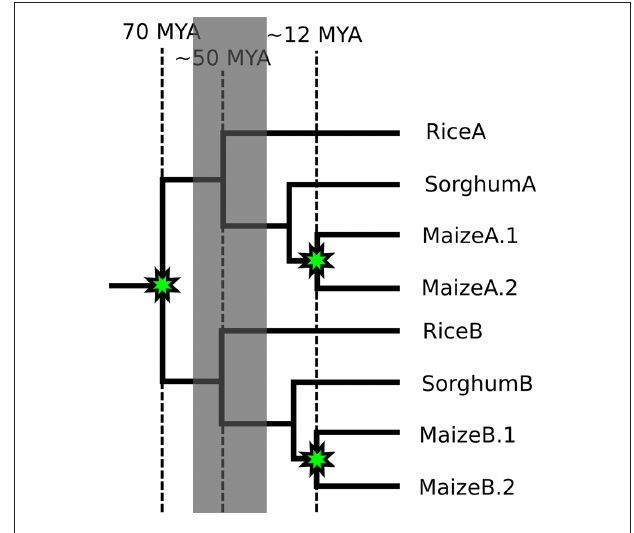
Figure 1 | A phylogenetic tree showing the relationships of homeologous and orthologous regions of the genomes of maize, sorghum, and rice. Genomic relationships between the species rice, sorghum, and maize. Nodes marked with stars represent divergence by whole genome duplication. All other nodes represent divergence by